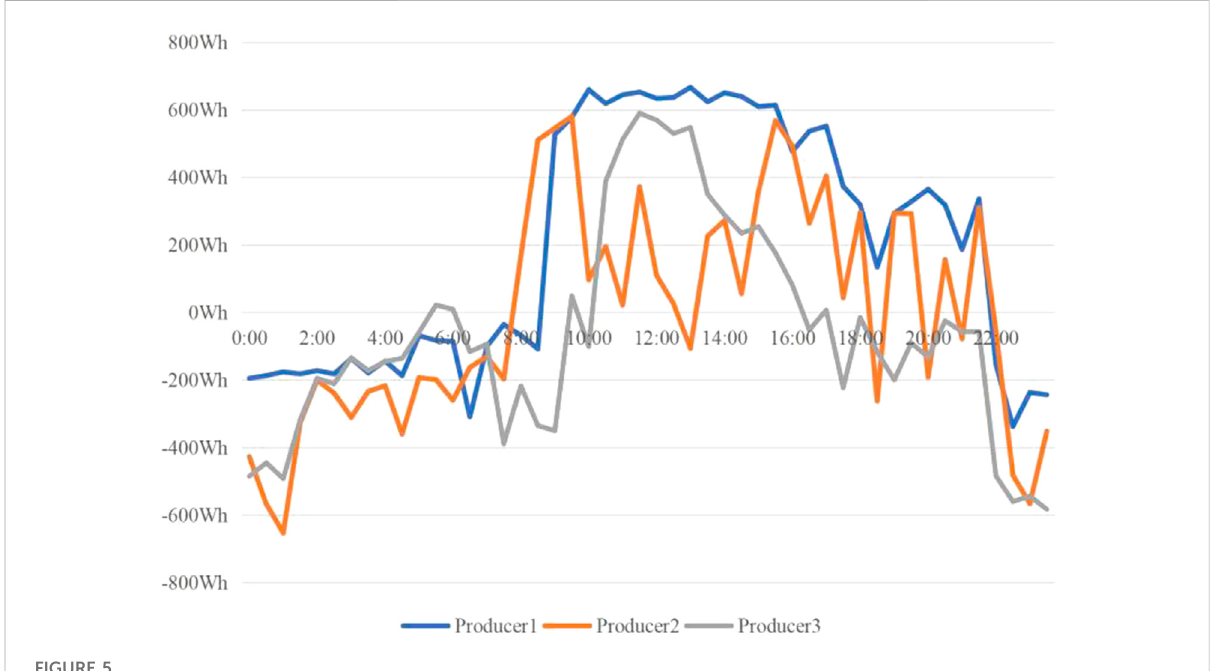
FIGURE 5 The daily net production curve of each prosumer.